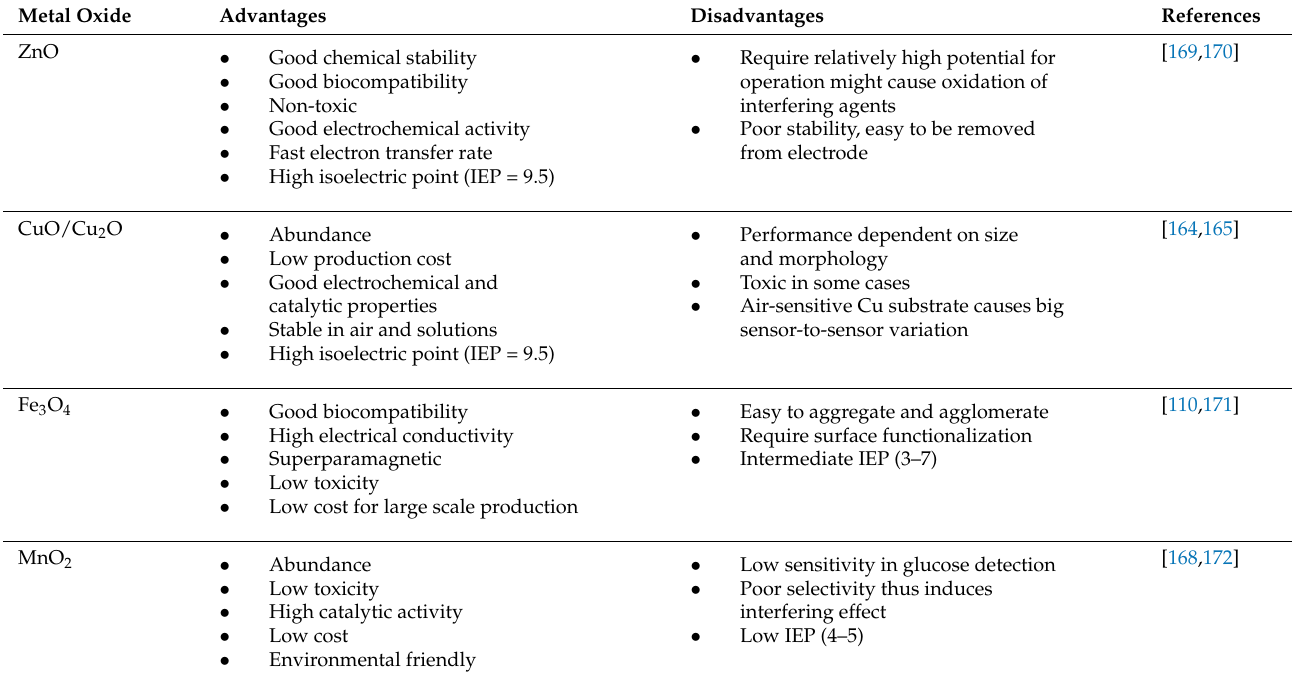
Table 4. The advantages and disadvantages of the common metal oxide nanostructured materials for glucose